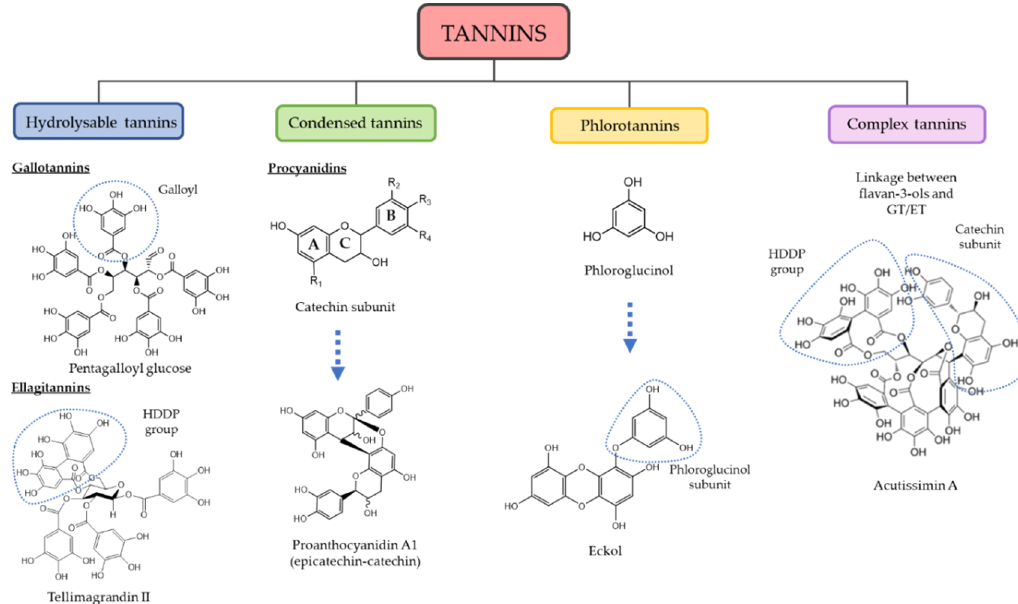
Figure 1. Classification and general representative structures of tannins. Functional groups are circled. Rings in catechin molecule are labeled as A, B and C. R = radical, H, OH; GT = gallotannins; ET = ellagitannins; HHDP = hexahydroxydiphenol .